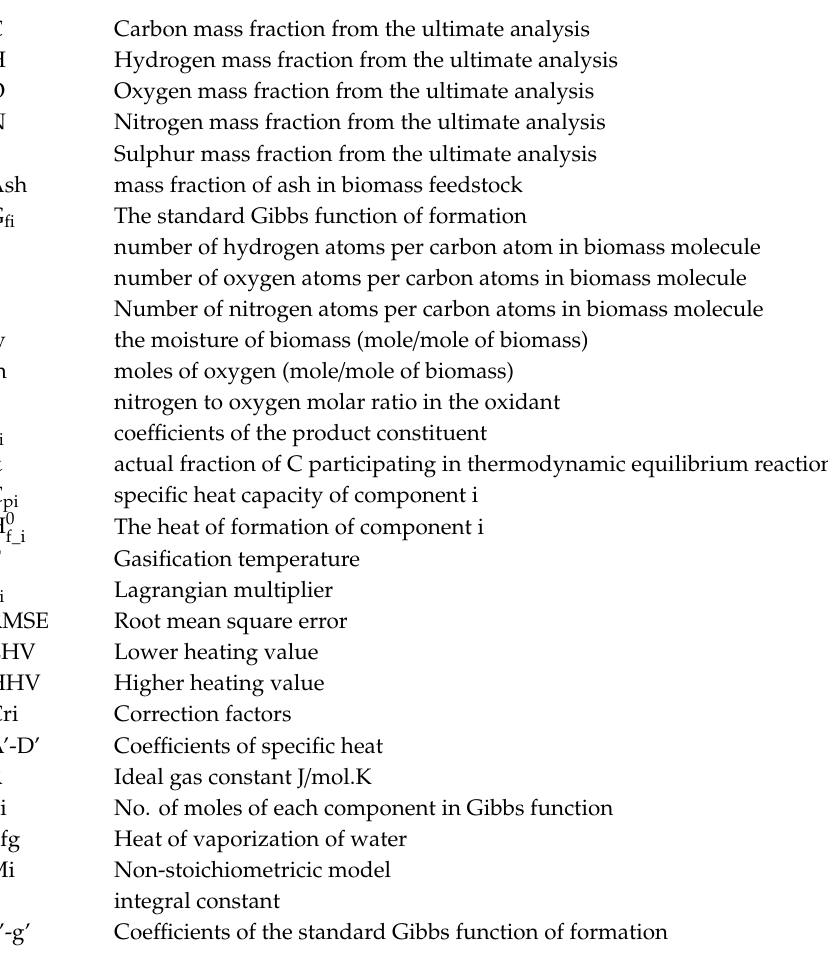
Figure S1: Training Data, Figure S2: Testing